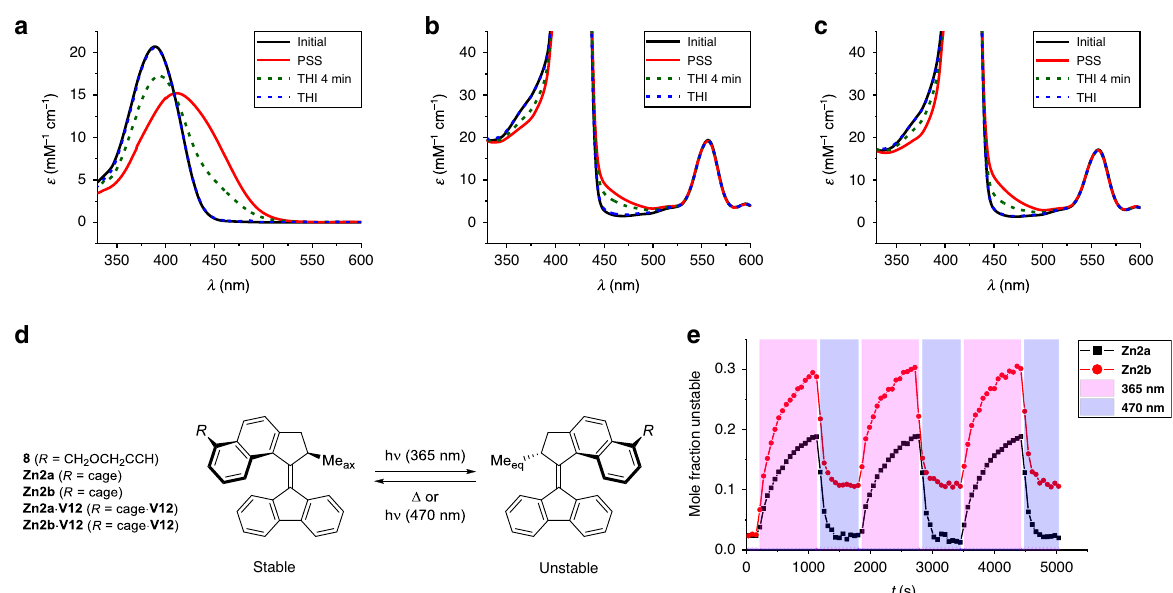
Fig. 5 Spectroscopic features of motor conjugates and their complexes with viologen guests. a – c UV-vis absorption spectra of a motor 8 , b Zn2a , and c Zn2b before irradiation (blue), after irradiation ( λ = 365 nm) to PSS (red), after partial thermal helix inversion (THI, green dashed line), and after full thermal helix inversion (blue dashed line) ( c = 10 − 5 M in CHCl 3 /CH 3 CN, 1:1, v/v, 298 K). d Photochemical and thermal isomerization of motor compounds. e Photochemical switching of Zn2a and Zn2b by irradiating alternately with λ = 365 nm and λ = 470 nm. Mole fractions were determined by 1 H NMR spectroscopy ( c = 10 − 3 M in CDCl 3 /CD 3 CN, 1:1, v/v).